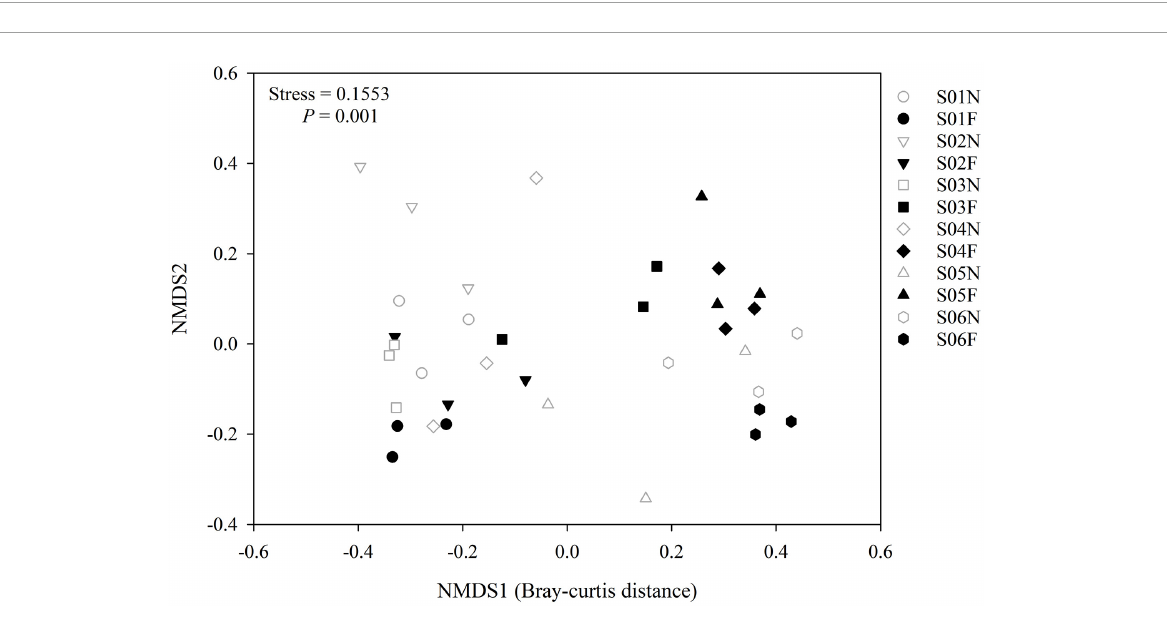
FIGURE6 Non-metric multidimensional scaling (NMDS) ranking according to the AM fungal community differences (Bray-Curtis distance) identified at each sampling site. Permutational multivariate analysis of variance (PERMANOVA) was adopted to compare community composition among different soil